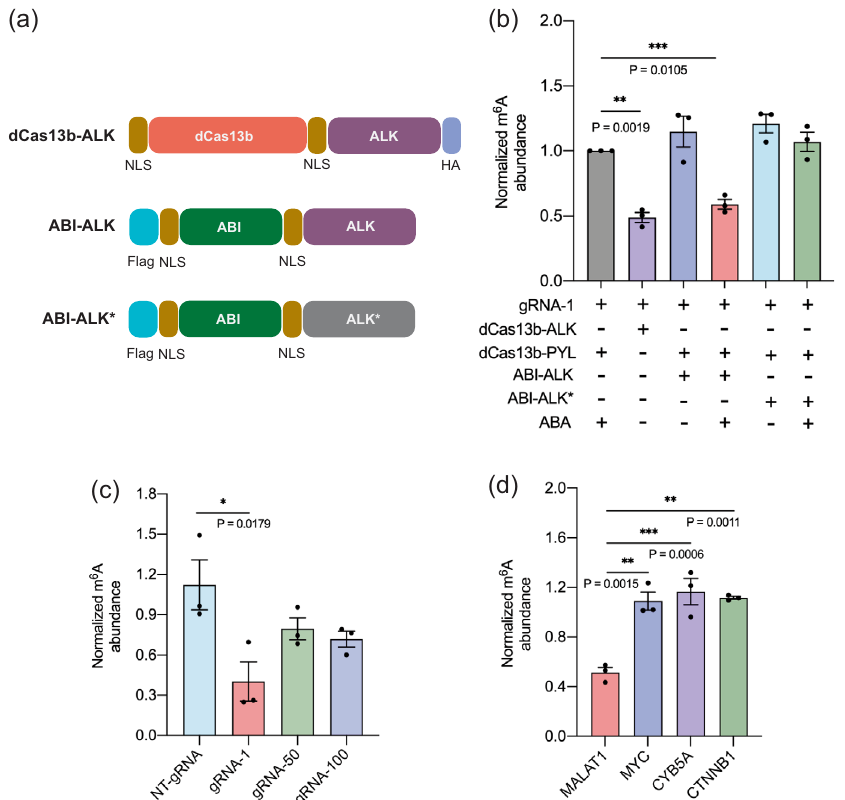
Fig. 4 ABA-induced m 6 A erasing at the MALAT1 RNA A2577 site in HeLa cells. a DNA constructs for the ABA-inducible m 6 A erasing system, including dCas13b-ALKBH5, ABI-ALK (with the wild-type ALKBH5), and ABI-ALK* (ALKBH5 with H204A and H267A mutations). b The m 6 A level changes under different editing conditions using the ABA-inducible or non-inducible m 6 A erasing system. c The m 6 A level changes using the ABA-inducible m 6 A erasing system with different gRNAs. d The m 6 A level changes at different RNA sites ( MALAT1 A2577, MYC A5553, CYB5A A135, CTNNB1 A126) using an inducible m 6 A erasing system targeting the MALAT1 A2577 site. All results of groups in a – c with different treatments were normalized to the group of dCas13b-PYL with gRNA-1 and ABA treatment. Values and error bars re fl ect the mean, s.e.m. of three independent biological replicates. P values are shown in the charts are determined by one-way ANOVA. Source data are provided as a Source Data fi